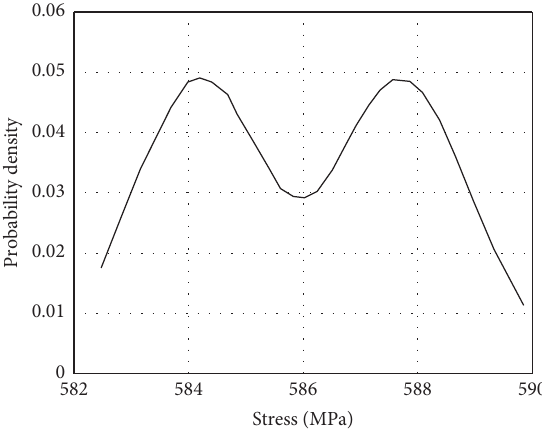
Figure 7: The probability density of tensile stress in cable sector 9 due to temperature effects.